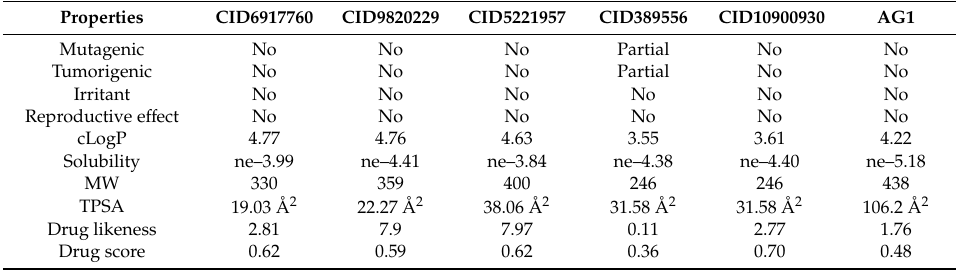
The best five compounds of ADMET properties are calculated by Osiris molecular property